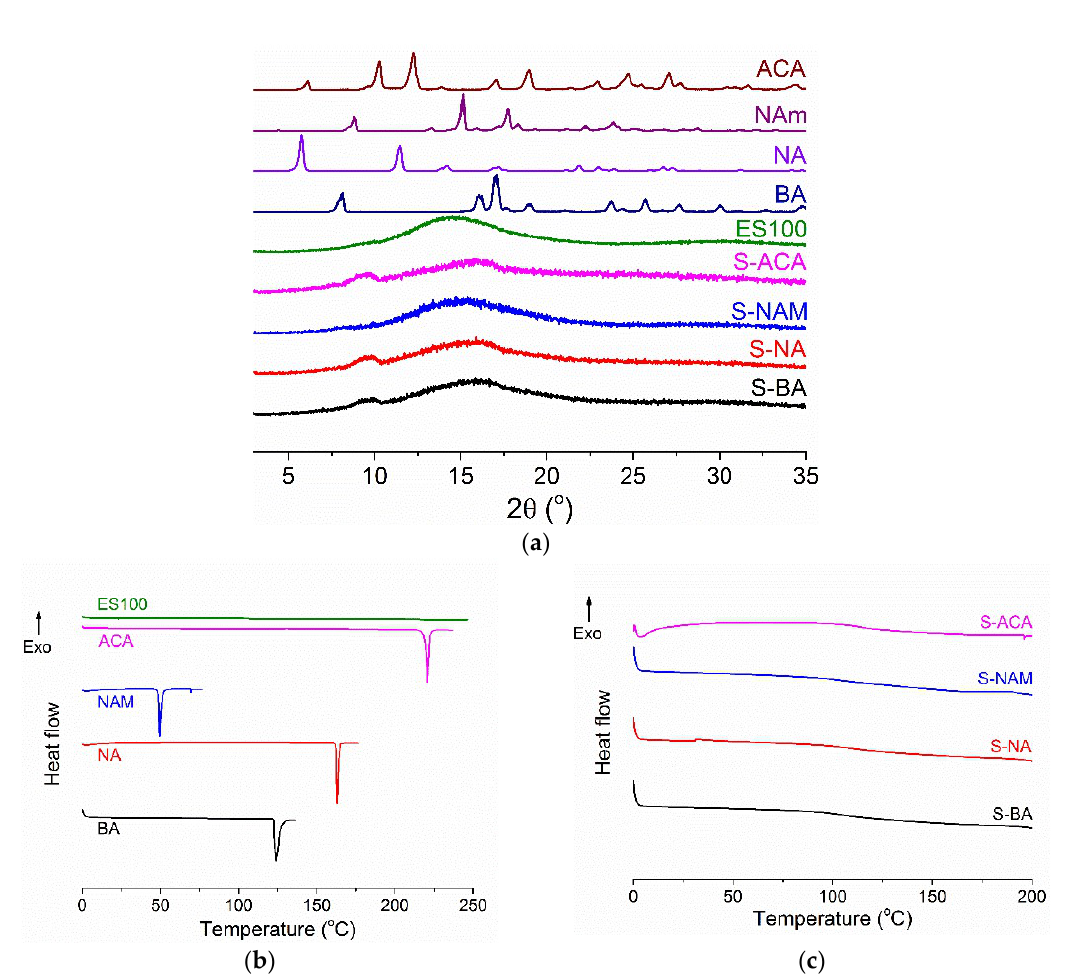
Figure 3. ( a ) XRD data and DSC data on ( b ) the raw materials and ( c ) formulations from monoaxial electrospinning. The data in ( a ) are normalized for ease of comparison.